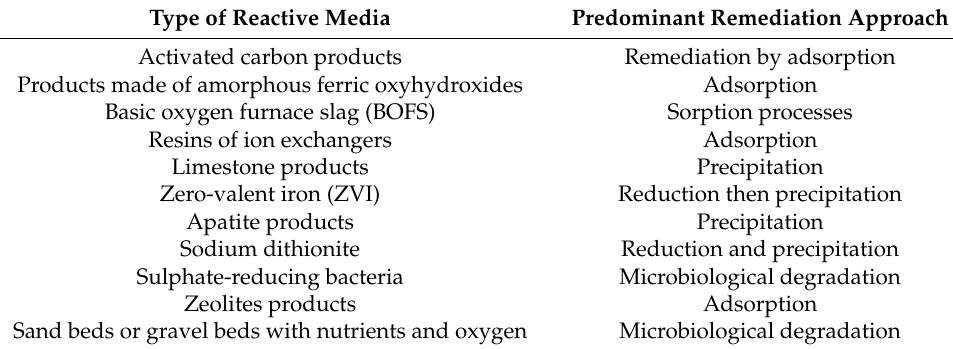
Table 3. Reactive media for the remediation of groundwater contaminated by metals and radionu- clides (Bronstein,